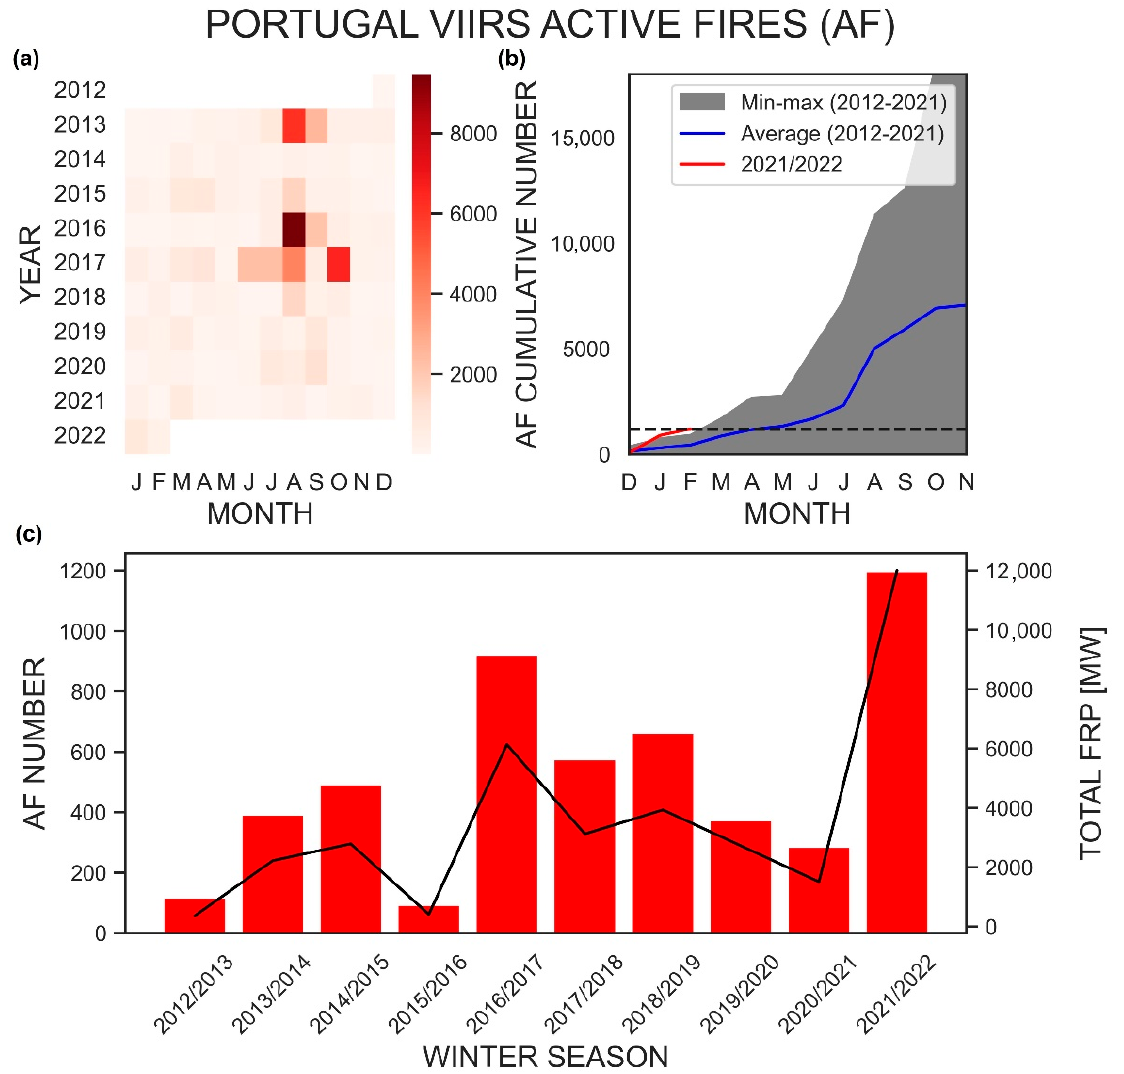
Figure 2. VIIRS data: ( a ) active fires between December 2012 and February 2022; ( b ) monthly cumu- lative active fires, dashed line indicates the winter 2021/2022 AF number; ( c ) seasonal cumulative number of active fires (red columns, left Y -axis) and Fire Radiative Power (FRP; black line, right Y -axis) for 10 wintertime periods.